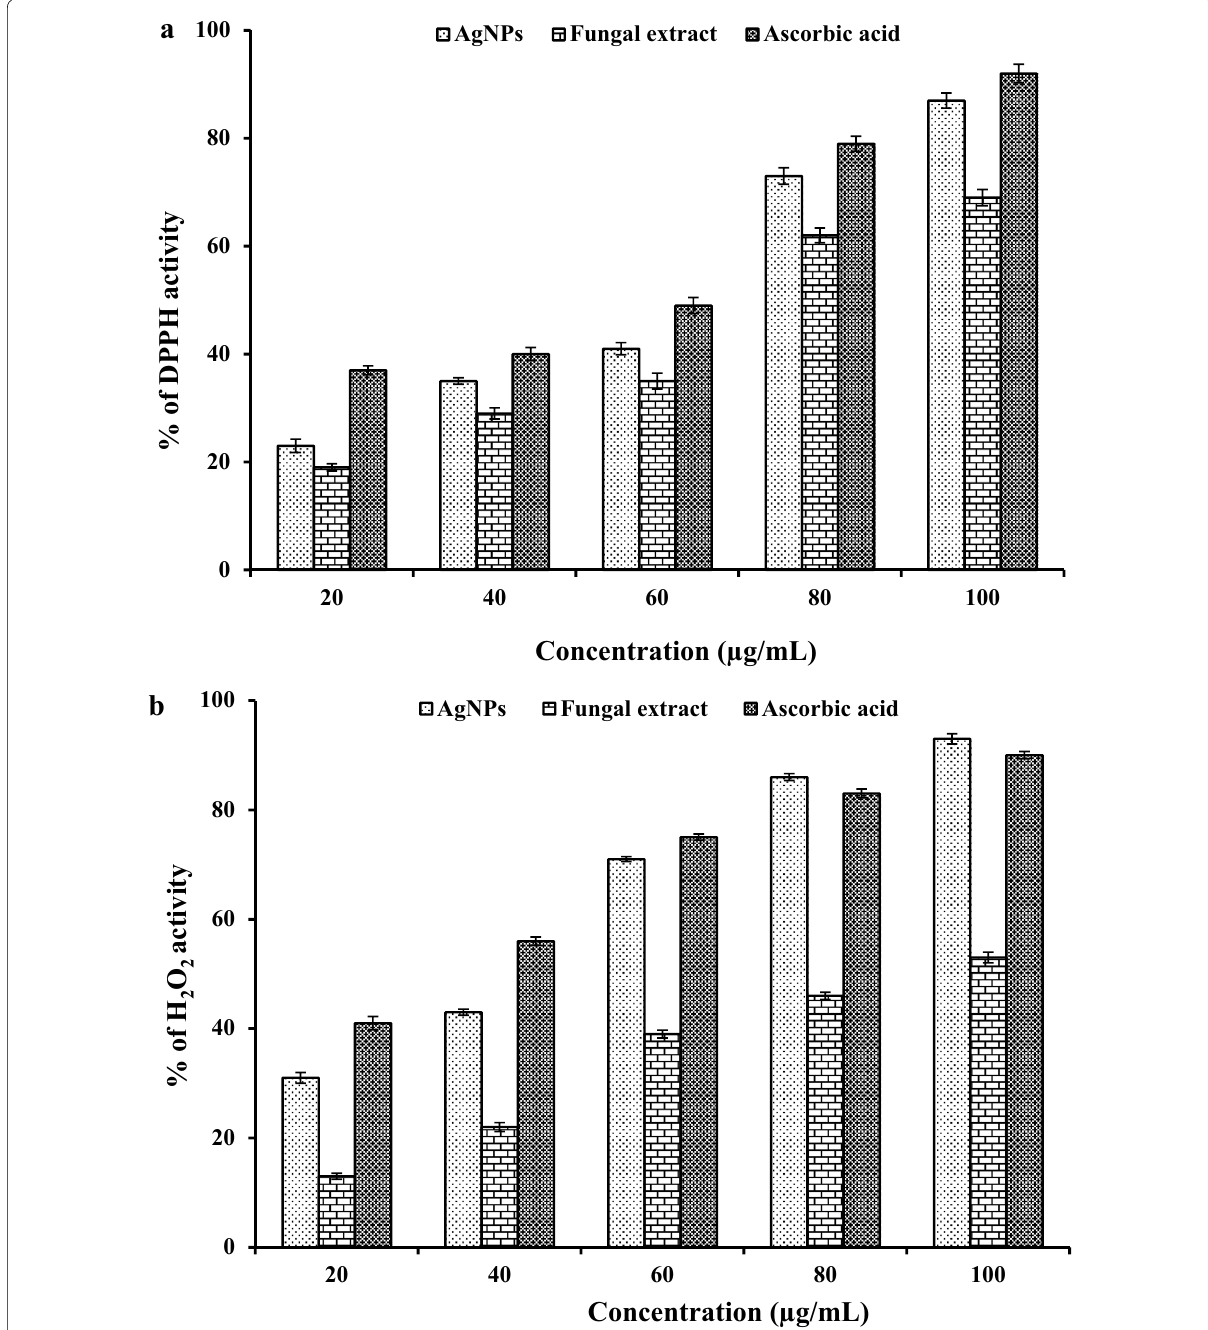
Fig. 8 Antioxidant activities of synthesized silver nanoparticles. a DPPH free radical scavenging activity. b H 2 O 2 scavenging